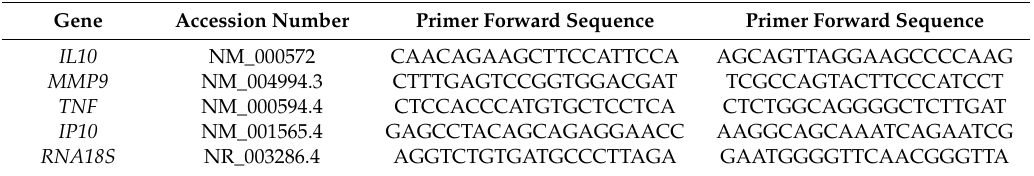
Table 3. Primer sequences used for